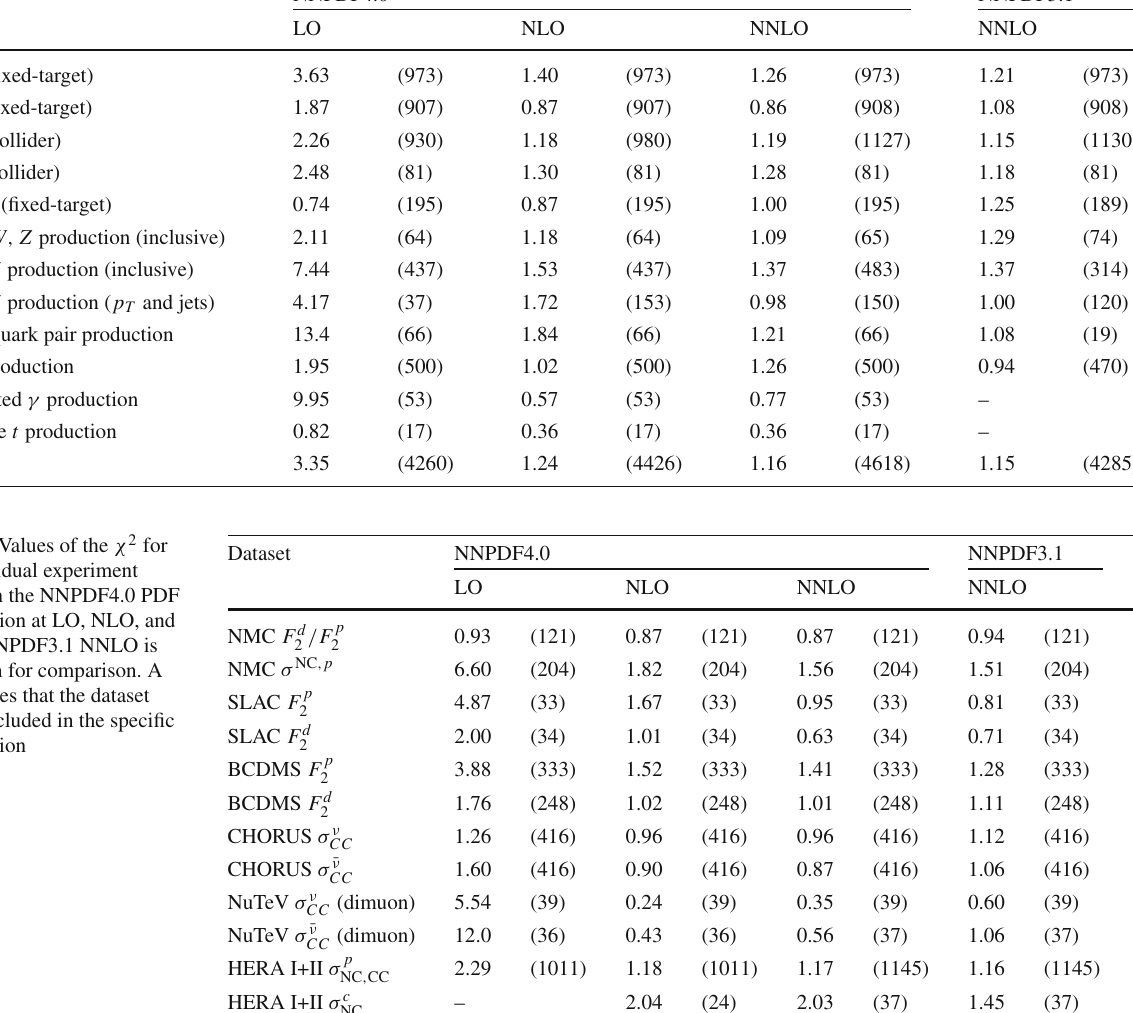
Table 18 Overview of χ 2 value by process type for the LO, NLO, and NNLO NNPDF4.0 baseline fits; NNLO NNPDF3.1 is also shown for comparison Dataset